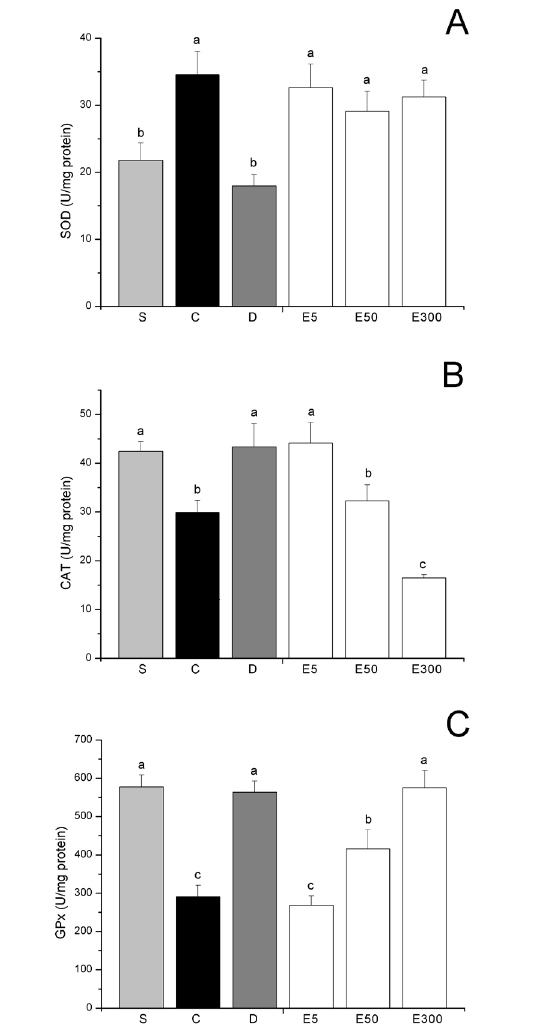
FIGURE 6 - Effect of the treatments on the activity of antioxidant enzymes in rats’ peritoneal neutrophils. A. Superoxide anion (SOD). B. Catalase (CAT). C. Glutathione peroxidase (GPx). Results are presented as means ± SD of six animals per group. S = saline group; C = carrageenan group; D = dexamethasone group; E5, E50 and E300 = extracts groups. Different letters indicate statistical significance